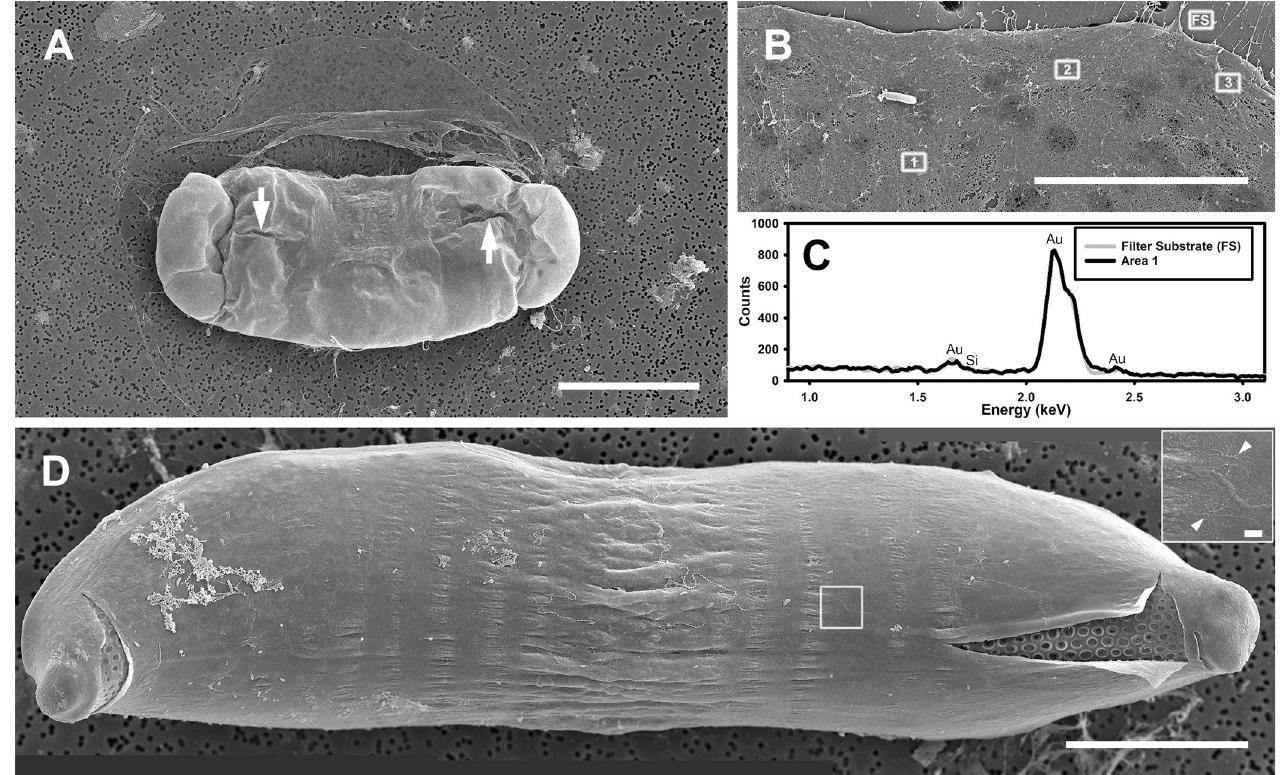
Fig 8. Older and mature auxospores (SEM/EDS, fixed/critical point dried specimens). (A) Ventral side of an oblong auxospore surrounded by remains of delicate shroud. Note rigid siliceous apical caps and gap between open, aligned TP bands (arrows). (B) Fine structure of shroud from (A). Framed numbers and FS indicate where EDS spectra were acquired from shroud and control filter surface. (C) Spectrum from Area 1 compared to spectrum of filter substrate. None of the areas shown here demonstrate presence of silicon. (D) Nearly intact mature auxospore wall enclosing initial valve. Note remains of a few dendritic scales (insert; arrowheads) and parallel ribbing of auxospore wall in midsection. Digital montage of three separate images. Scale bars: A, 50 μ m; B, 10 μ m; D, 40 μ m; D insert, 1 μ m.